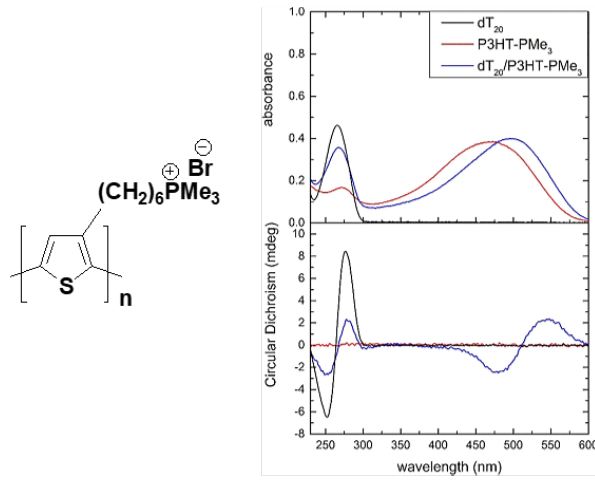
Figure 11. Chemical structure of the cationic (P3HT-PMe3) ( left ) and UV-Vis and CD spectra of dT20 (black line), P3HT-PMe3 (red line) and dT20(oligonucletide) / P3HT-PMe3 complex (blue line) at a 1:1 DNA/polymer charge ratio. Reproduced with permission [86].